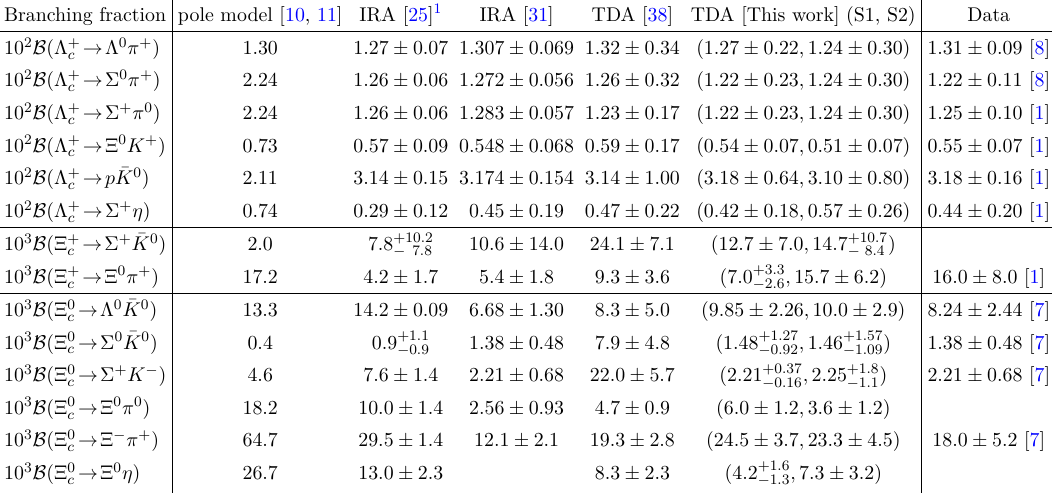
Table 5 . Cabibbo-allowed (CA) branching fractions.